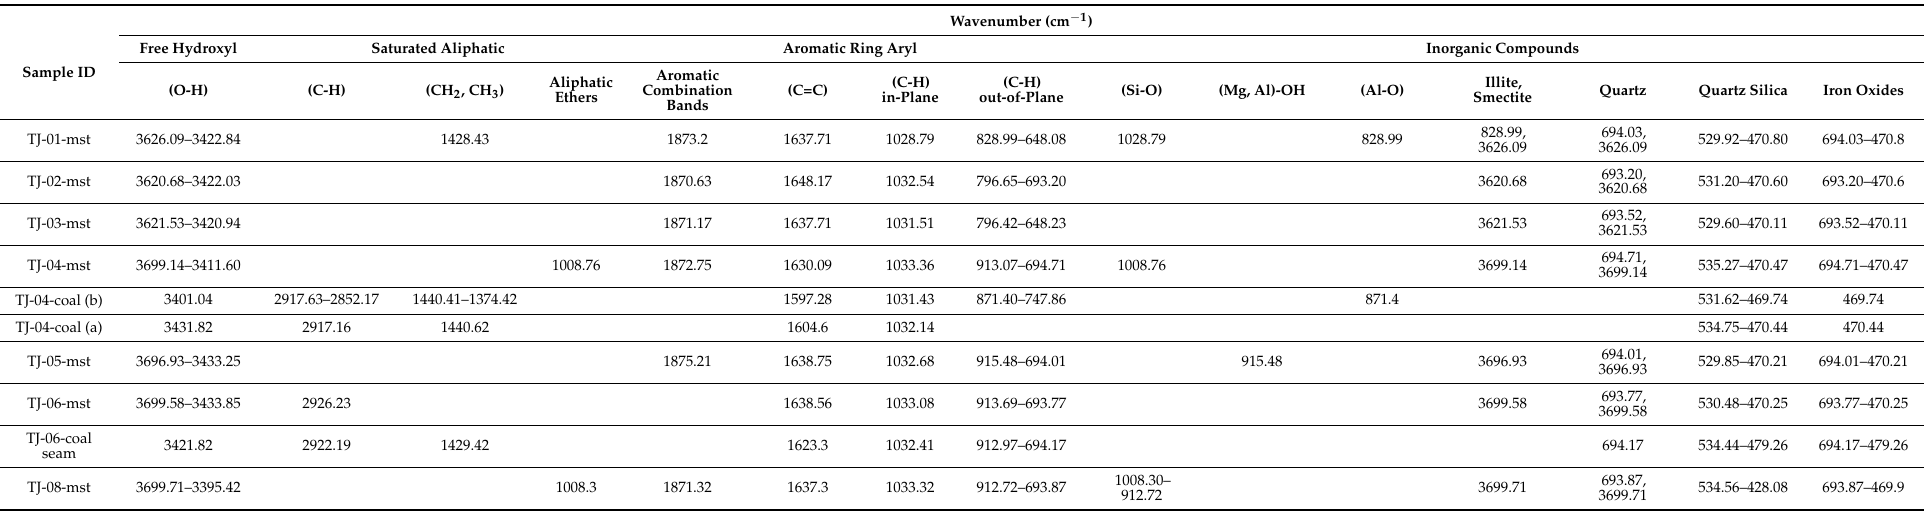
Table 4. Functional groups distinguished from FTIR spectra of the Tanjong Formation mudstone and coal